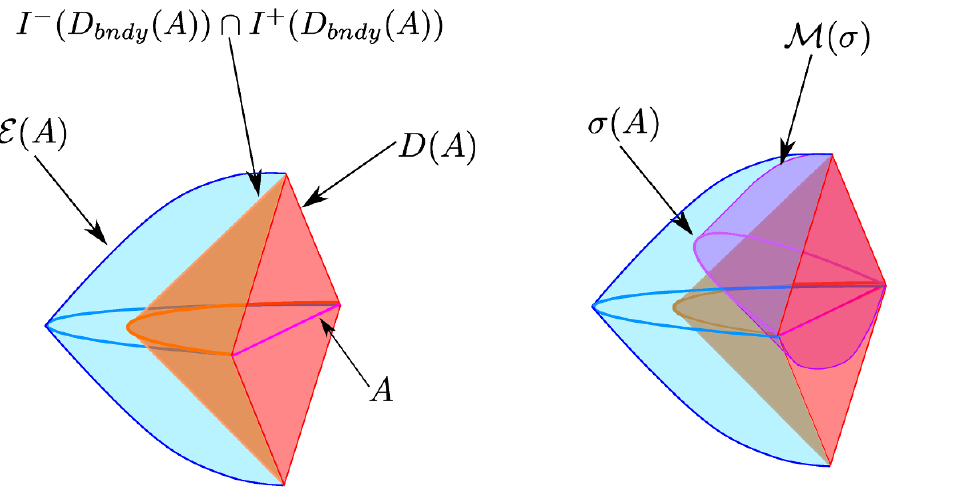
Figure 3 . Left: depiction of the Entanglement Wedge (blue) and Causal Wedge (orange). The entanglement wedge E ( A ) is the domain of dependence lying between the extremal surface m ( A ) and the boundary. In contrast, the causal wedge I (cid:0) ( D bndy ( A )) \ I + ( D bndy ( A )) is de(cid:12)ned as the intersection of the bulk past and future of the domain of dependence D bndy ( A ) in the boundary. The intersection of the past and future horizons de(cid:12)nes the causal surface. Right: depiction of the marginally trapped surface (cid:27) ( A ) which (as shown in section 3) must lie in the entanglement wedge but above the future horizon of D bndy ( A ). The associated marginally trapped wedge M ( (cid:27) ) is also shown (purple).